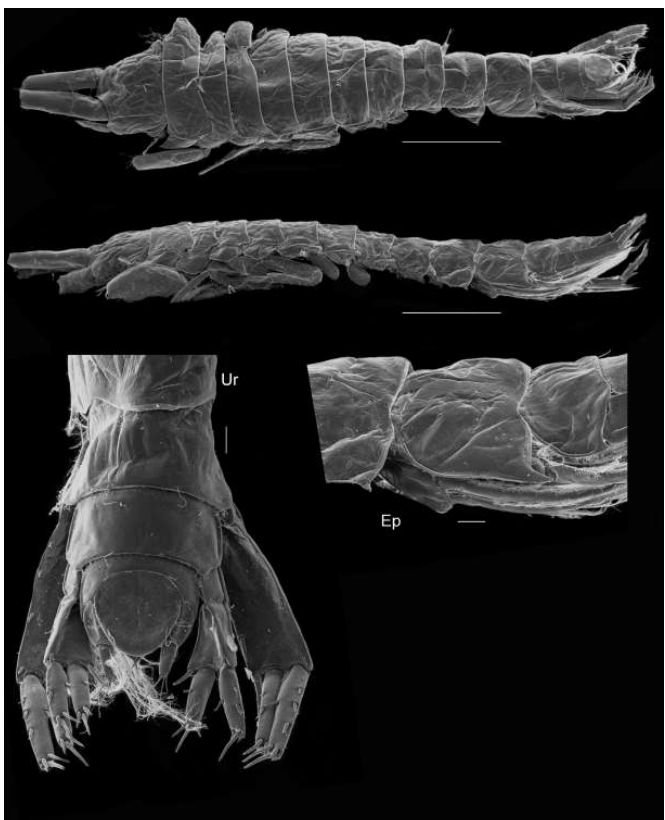
Figure 16. Unciola icelandica sp. nov. SEM image, paratype female, 6 mm, ZMHK-56725, South Island, Iceland Basin North 1921 m. Scales: habitus 1 mm, urosome 100 µm.